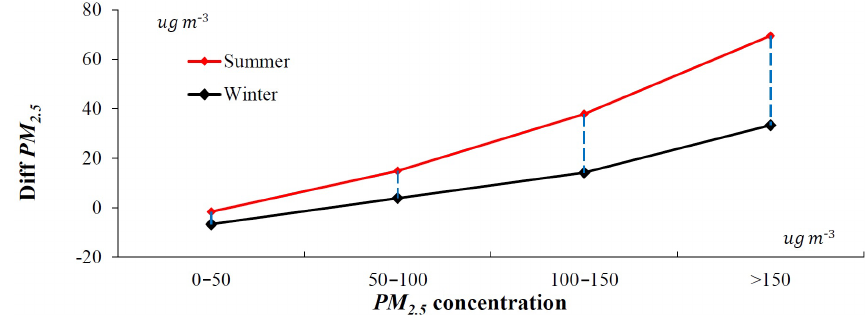
Figure 6. Summertime (red curve) and wintertime (black curve) urban–rural PM 2 . 5 concentration mean differences (unit: µgm − 3 ) of all